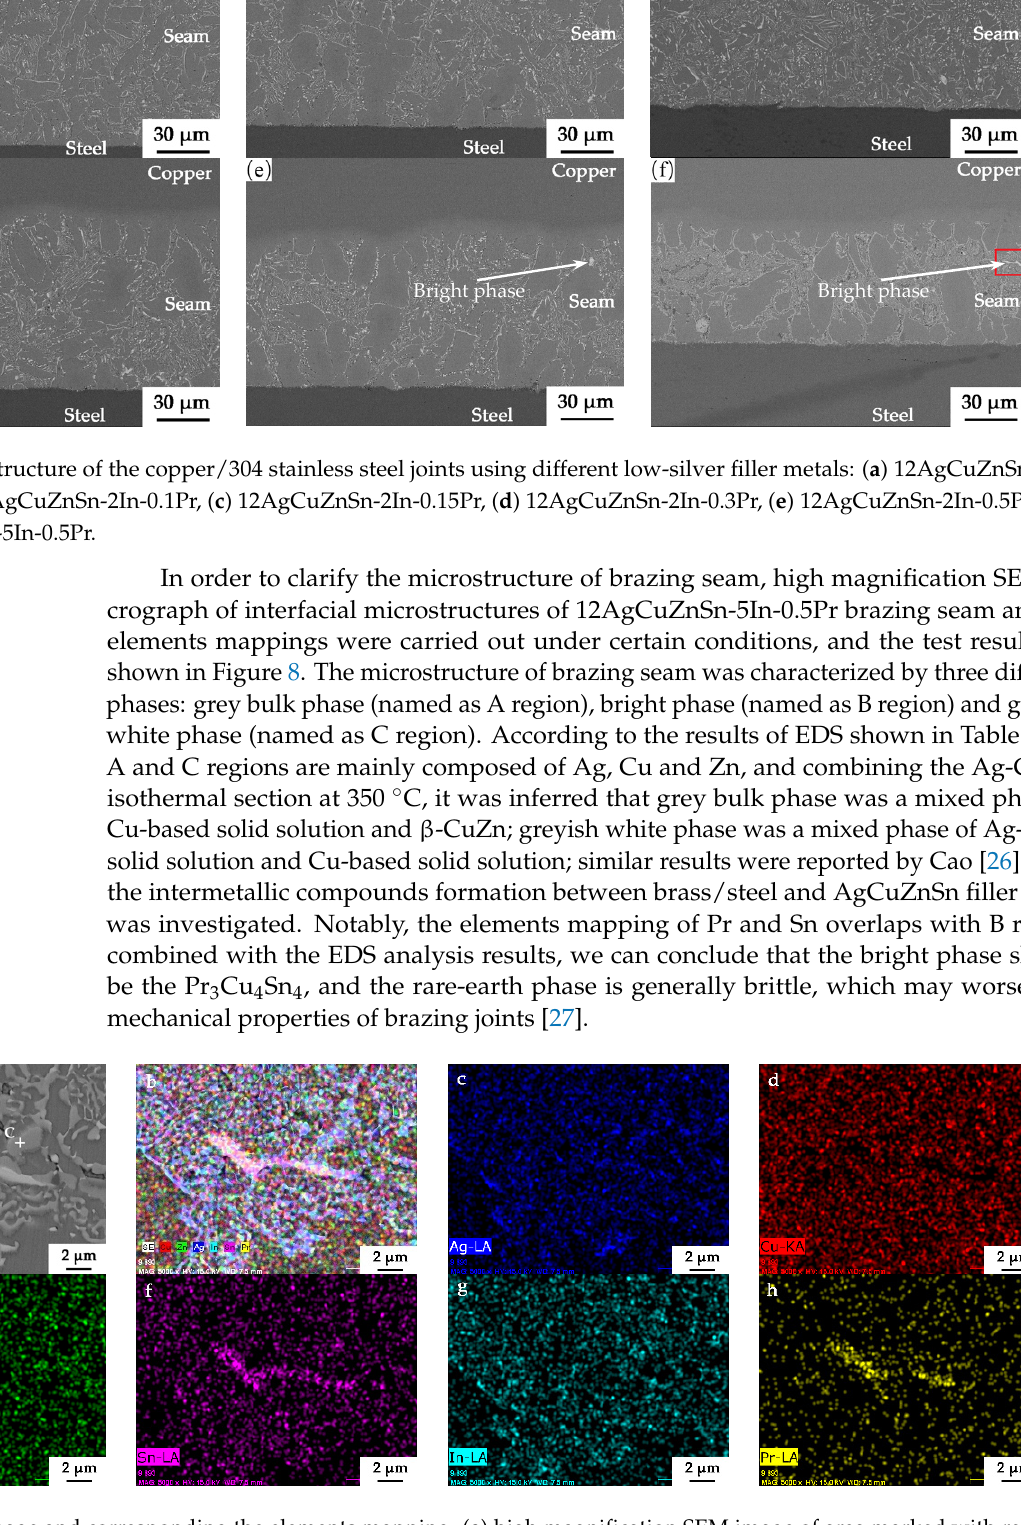
Figure 8. SEM image and corresponding the elements mapping. ( a ) high magnification SEM image of area marked with red square in Figure 7f, ( b ) the elements mapping, ( c ) Ag, ( d ) Cu, ( e ) Zn, ( f ) Sn, ( g ) In, ( h ) Pr.